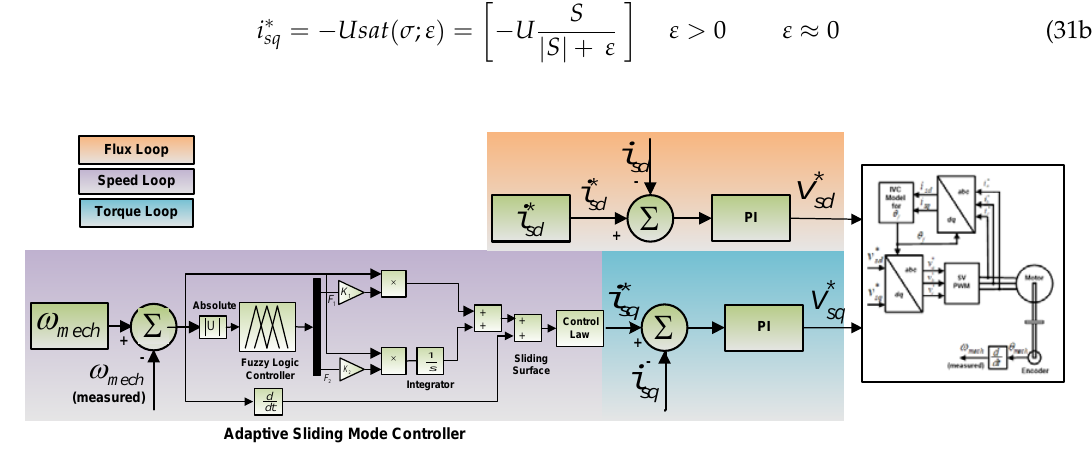
Figure 10. Hybrid controller design.